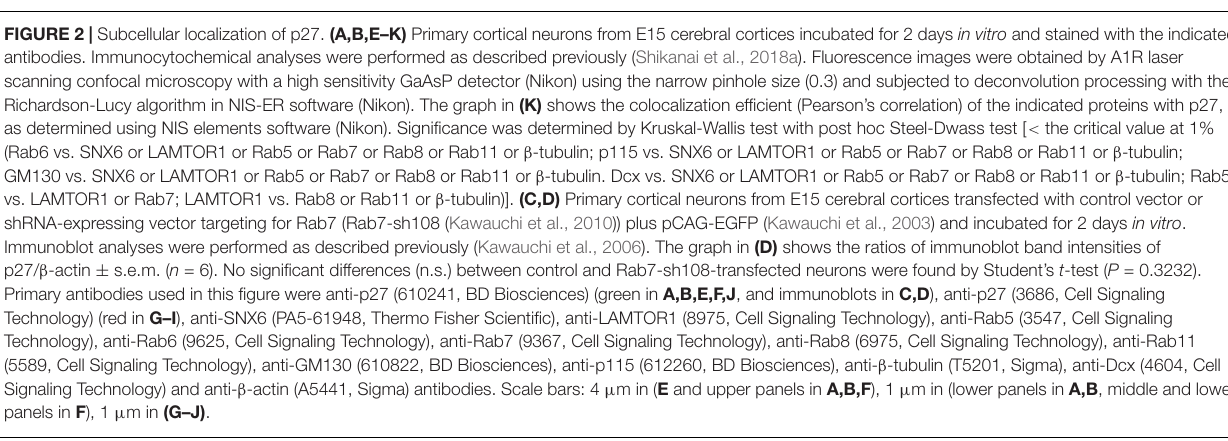
FIGURE 2 | Subcellular localization of p27. (A,B,E–K) Primary cortical neurons from E15 cerebral cortices incubated for 2 days in vitro and stained with the indicated antibodies. Immunocytochemical analyses were performed as described previously (Shikanai et al., 2018a). Fluorescence images were obtained by A1R laser scanning confocal microscopy with a high sensitivity GaAsP detector (Nikon) using the narrow pinhole size (0.3) and subjected to deconvolution processing with the Richardson-Lucy algorithm in NIS-ER software (Nikon). The graph in (K) shows the colocalization efficient (Pearson’s correlation) of the indicated proteins with p27, as determined using NIS elements software (Nikon). Significance was determined by Kruskal-Wallis test with post hoc Steel-Dwass test [ < the critical value at 1% (Rab6 vs. SNX6 or LAMTOR1 or Rab5 or Rab7 or Rab8 or Rab11 or β -tubulin; p115 vs. SNX6 or LAMTOR1 or Rab5 or Rab7 or Rab8 or Rab11 or β -tubulin; GM130 vs. SNX6 or LAMTOR1 or Rab5 or Rab7 or Rab8 or Rab11 or β -tubulin. Dcx vs. SNX6 or LAMTOR1 or Rab5 or Rab7 or Rab8 or Rab11 or β -tubulin; Rab5 vs. LAMTOR1 or Rab7; LAMTOR1 vs. Rab8 or Rab11 or β -tubulin)]. (C,D) Primary cortical neurons from E15 cerebral cortices transfected with control vector or shRNA-expressing vector targeting for Rab7 (Rab7-sh108 (Kawauchi et al., 2010)) plus pCAG-EGFP (Kawauchi et al., 2003) and incubated for 2 days in vitro . Immunoblot analyses were performed as described previously (Kawauchi et al., 2006). The graph in (D) shows the ratios of immunoblot band intensities of p27/ β -actin ± s.e.m. ( n = 6). No significant differences (n.s.) between control and Rab7-sh108-transfected neurons were found by Student’s t -test ( P = 0.3232). Primary antibodies used in this figure were anti-p27 (610241, BD Biosciences) (green in A,B,E,F,J , and immunoblots in C,D ), anti-p27 (3686, Cell